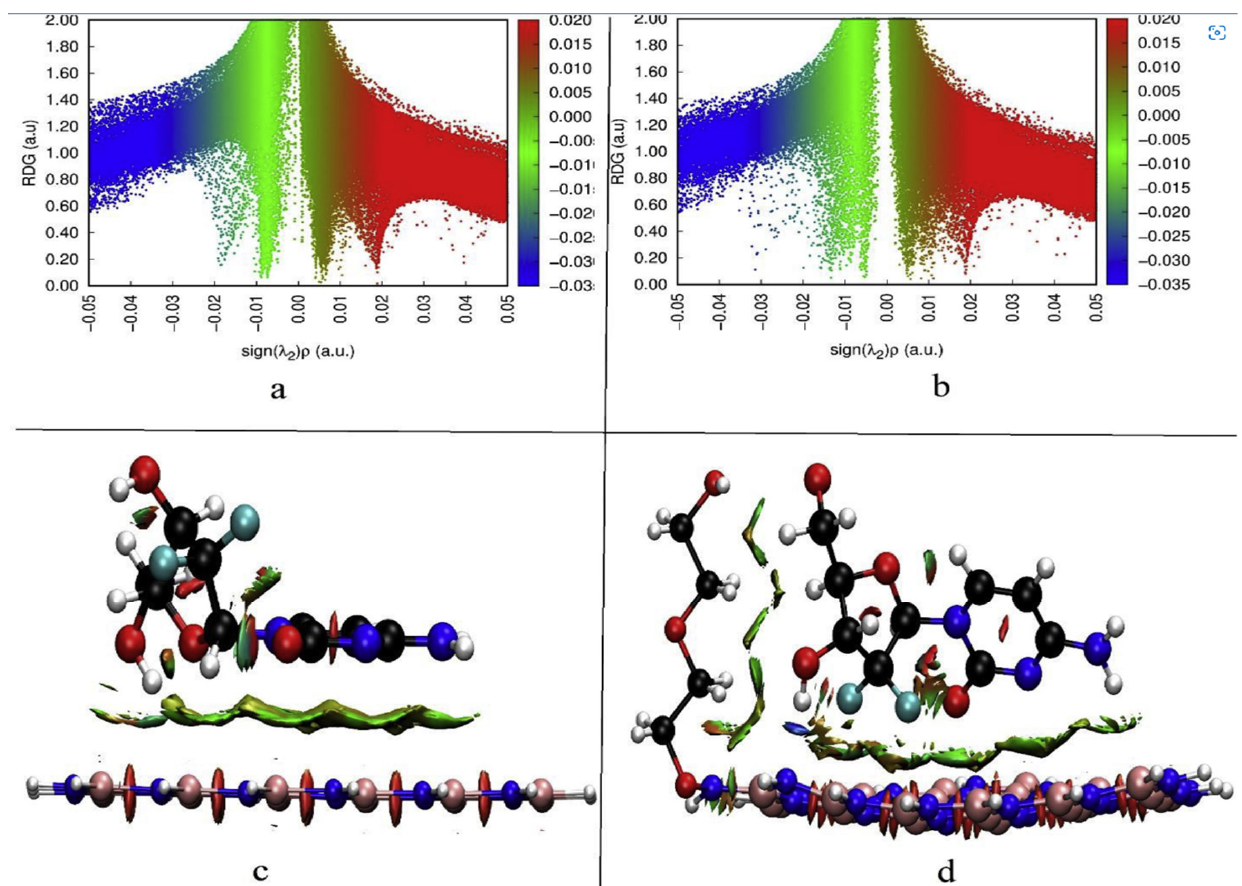
Figure 9. The RDG vs. sign( λ 2 ) ρ plots (top) and the color-filled RDG iso-surfaces (bottom) of the drug–carrier complex depict noncovalent interaction (NCI) regions for the non-functionalized (h- BN) ( a , b ) and functionalized (PEG-h-BN) ( c,d ) model. Reproduced with permission from ref. [11]; Copyright 2020, Elsevier Science Ltd.